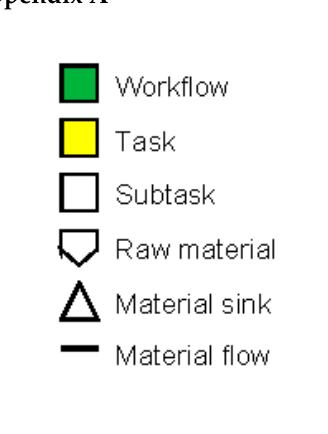
Figure A1. Recipe network Symbols.